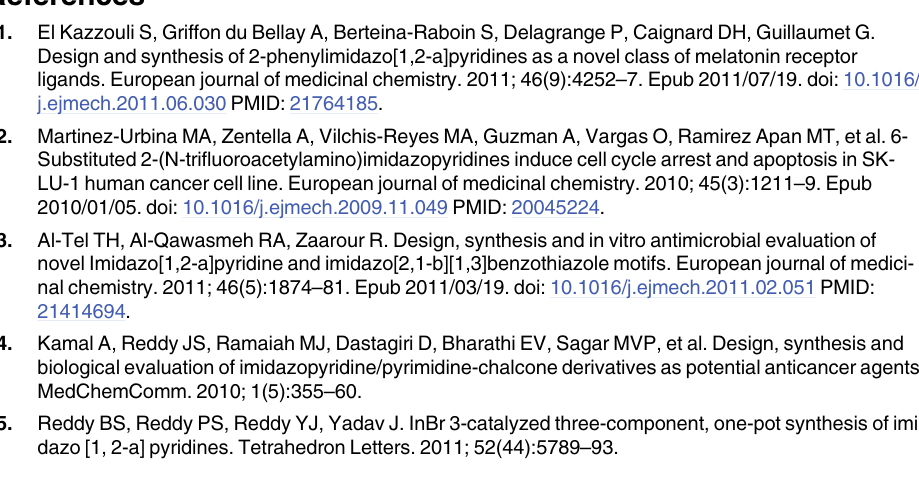
Fig 4. Predicted interactions of imidazopyridine 3f with PLA 2 : PLA 2 is shown as green cartoon with highlighted Trp-31 and peptide bond to Gly-32. Co-crystallized ligand nimesulide is shown in stick representation with cyan carbon atoms. The highest scoring docking pose of compound 3f is shown in purple sticks. In silico docking predicts π - π stacking interactions with Trp-31 and additional amide- π interactions with the backbone of